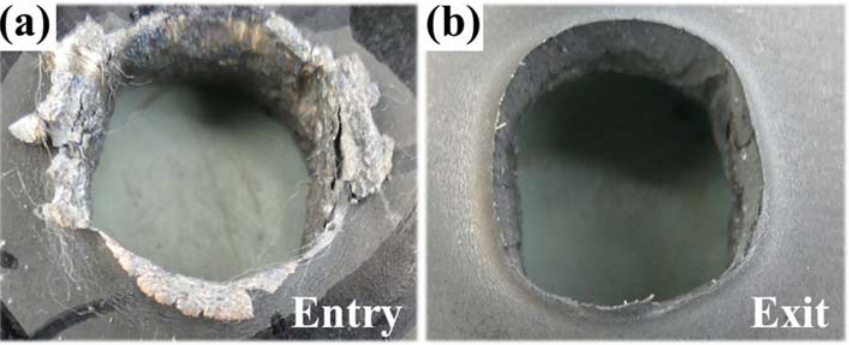
Figure 9. Holes formed in the process of the fragment penetrating A 3 plate: ( a ) Entry and ( b ) Exit.